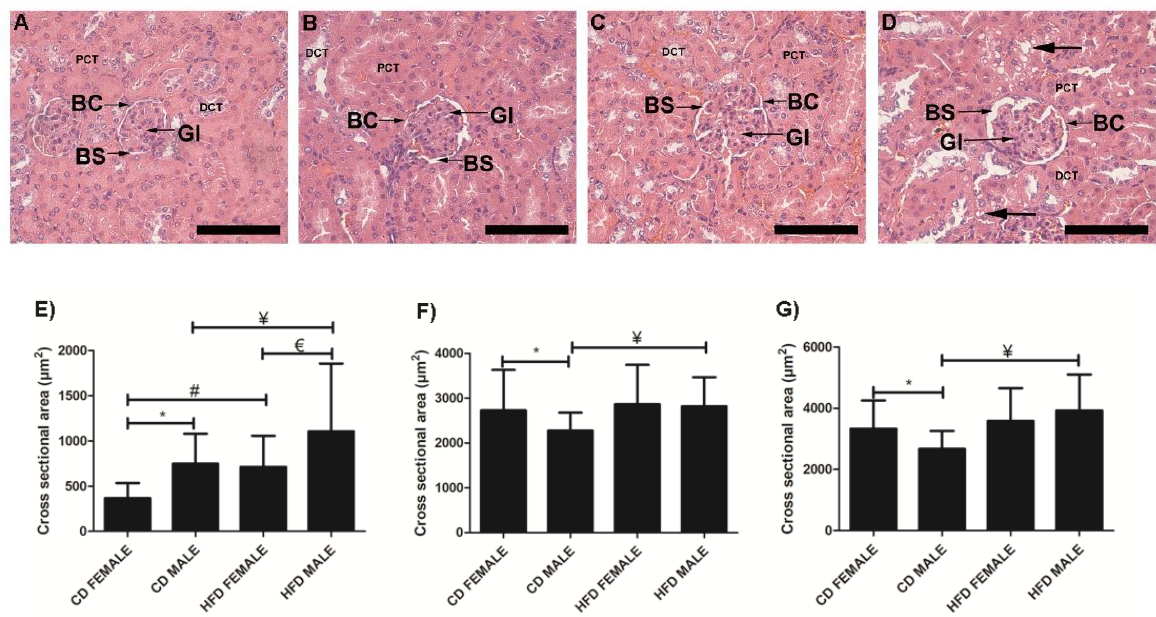
Figure 8. Histology of kidney tissue harvested from CD females, ( A ); CD males, ( B ); HFD females, ( C ); and HFD males, ( D ); showing the glomeruli (Gl), Bowman’s space (BS), Bowman’s capsule (BC), surrounding proximal convoluted tubules (PCT) and distal convoluted tubules (DCT). Cross-sectional area of Bowman’s space, ( E ); glomeruli, ( F ); Bowman’s capsule, ( G ); measured from CD females, CD males, HFD females, and HFD males. The HFD females displayed a significantly enlarged Bowman’s space compared to CD females, E while HFD males displayed significantly enlarged glomerular area, F Bowman’s space, E and Bowman’s capsule, G compared to CD males. Lipid accumulation (black arrow) in the lining and wall of the renal tubule was evident in HFD males, ( D ). * Significant difference between CD females and CD males. # Significant difference between CD female and HFD female. ¥ Significant difference between CD male and HFD male. € Significant difference between HFD female and HFD male. p < 0.05. Mean ± SD. Scale bar: 100 µ m.